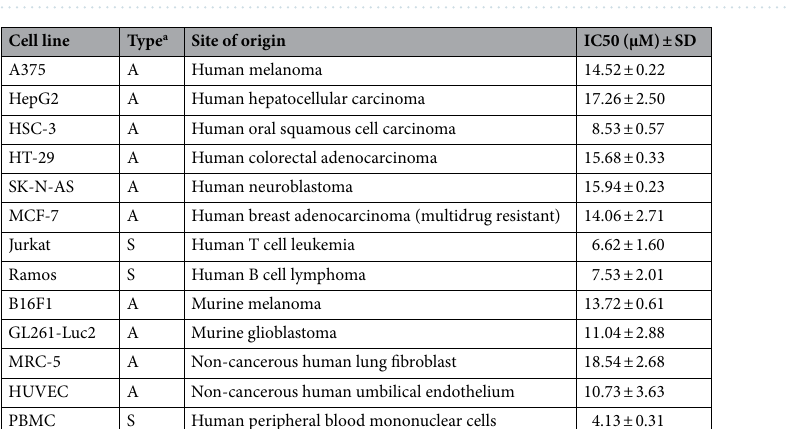
Figure 2. Synthesis of the amphipathic barbiturate MPM-1. Conditions: ( a ) 3-bromo-1-phenyl-1-propene, NaH, DMF, r.t.; ( b ) Pd/C, H 2 (10 bar), r.t.; ( c ) 10 equiv. urea (dry), NaH, DMF (dry), r.t.; ( d ) 10 equiv. 1,4-dibromobutane, 4 equiv. K 2 CO 3 , DMF (dry), r.t., 18–48 h; ( e ) 3 equiv. NaN 3 , DMF (dry); ( f ) i. NaBH 4 , 1,3-propanedithiol, THF:isopropanol 1:1, r.t.; ii. Boc 2 O, r.t.; ( g ) TFA, CH 2 Cl 2 .